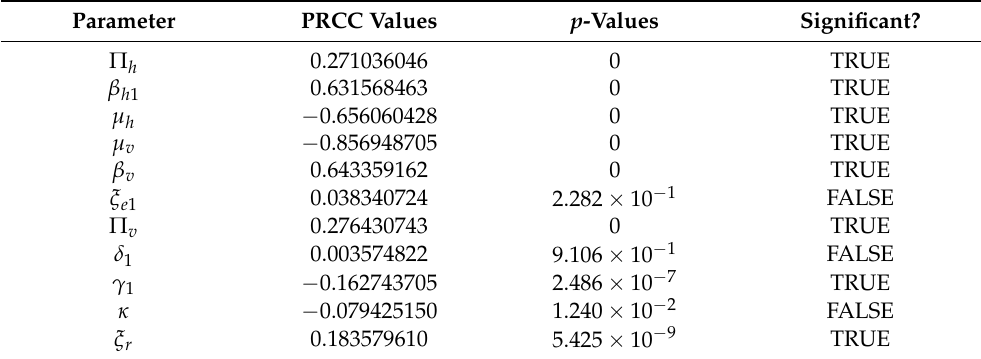
Figure 5. Tornado plot showing the PRCC values for the model parameters in R 0 . Table 4. PRCC parameter values and p -values for the global sensitivity analysis against R 0